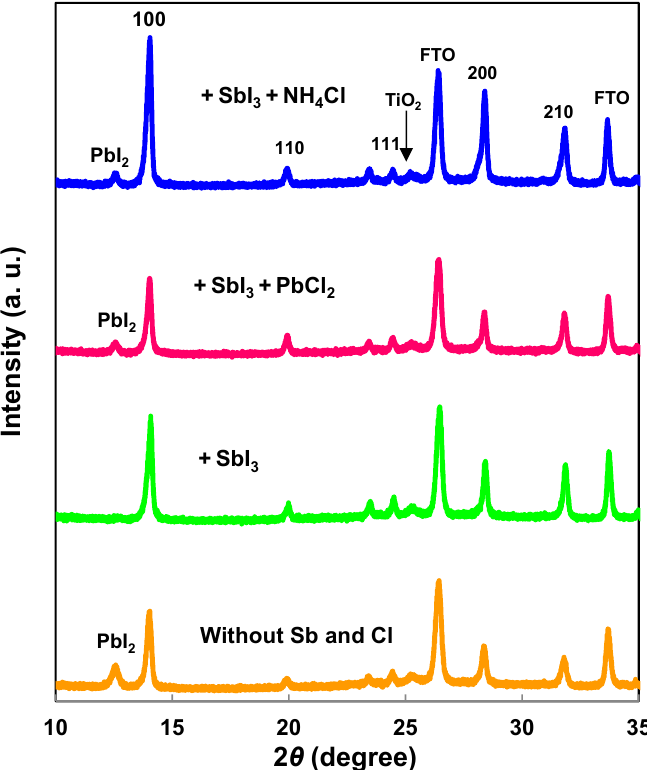
Figure 4. XRD patterns of CH 3 NH 3 Pb(Sb)I 3 (Cl) cells.